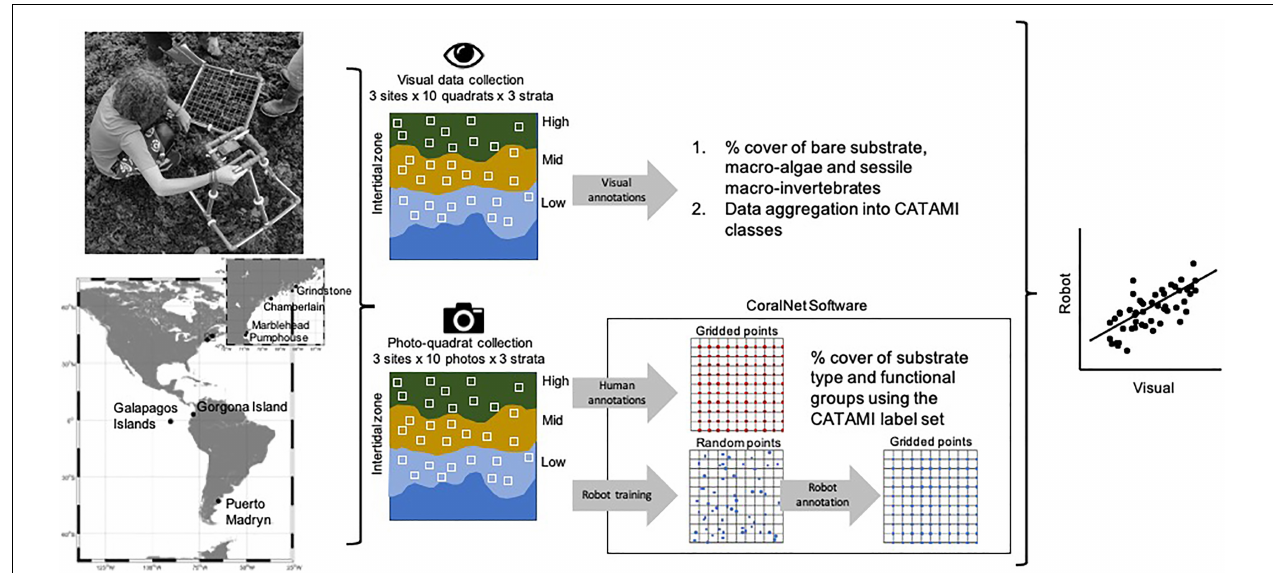
FIGURE 1 | Study workflow showing the location of sampling localities, in situ collection of visual observations, photoquadrat imagery from each locality, and data processing and analysis. The inset map represents the area highlighted with the rectangle containing the four sampled sites in the United States (Marblehead, Pumphouse, Chamberlain, and Grindstone). Visual annotations collected on the field (above the map) were used to estimate percent cover of all taxa to the lowest possible taxonomic level and subsequently aggregated into CATAMI categories. Note that photoquadrats were collected in the same place than visual quadrats. CoralNet software was employed to estimate percent cover of CATAMI categories from direct human annotations and automatically by machine learning after training the algorithm with 100 points randomly distributed over 362 photoquadrats. Outputs from visual and photoquadrat (human and automated) annotations were then compared and statistically